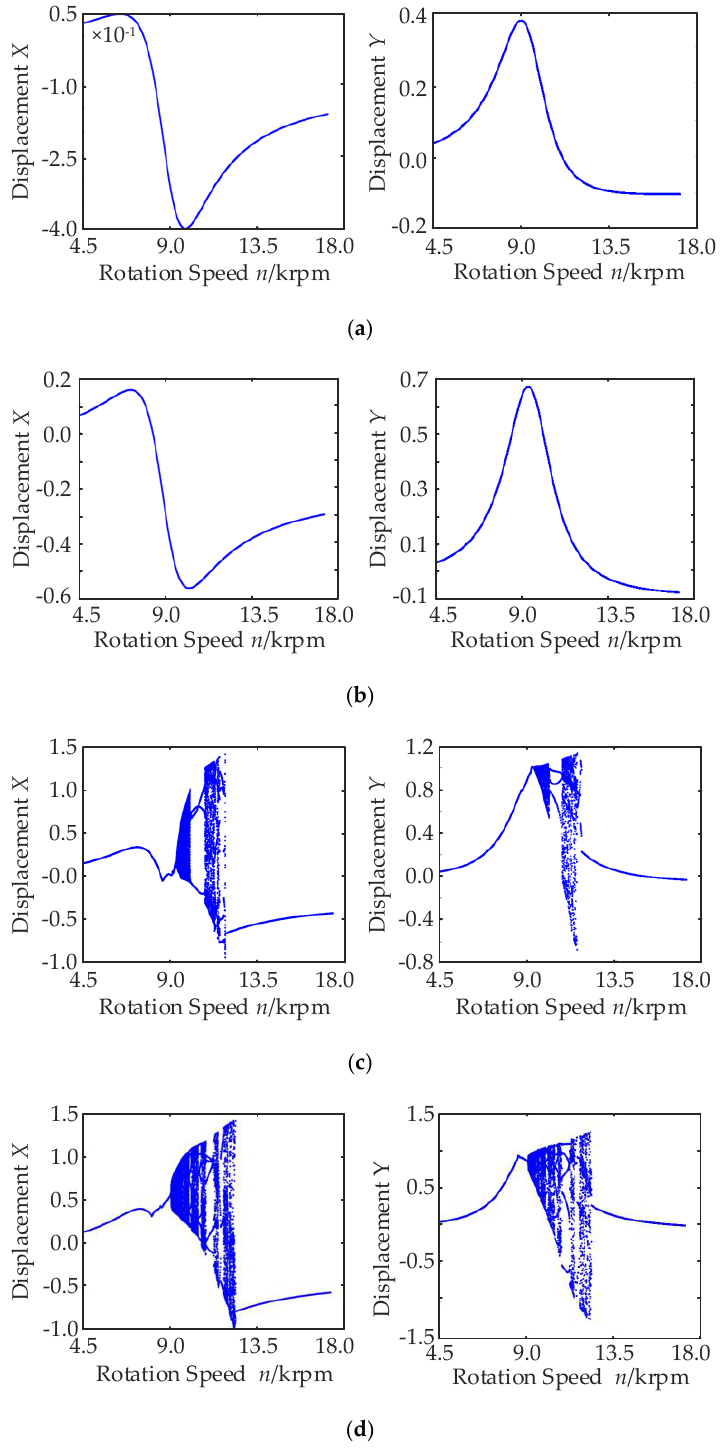
Figure 8. Rotor displacement with different eccentricity ratio. ( a ) U x = 0.1, U y = 0.1; ( b ) U x = 0.2, U y = 0.1; ( c ) U x = 0.3, U y = 0.1; ( d ) U x = 0.4, U y = 0.1.